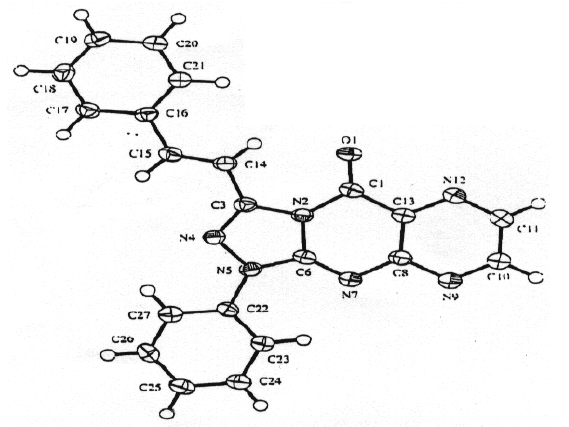
Figure 1. Diagram of compound 9a with crystallographic numbering